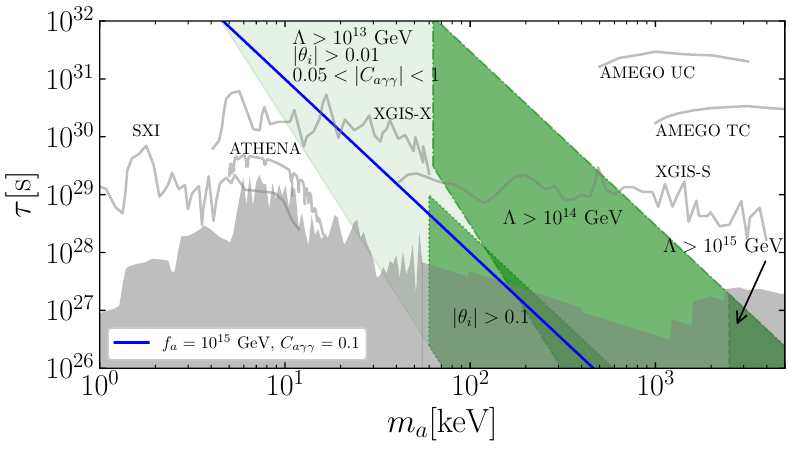
Figure 1 . Parameter space for heavy axion DM. The shaded green regions illustrate where the heavy axion can constitute all of DM subject to restrictions on Λ , the scale of the dim-6 operator mediating glueball decay, θ i , and C aγγ , as indicated. The reheat temperature after glueball decay is taken to be T RH > 5 MeV to satisfy the constraint from BBN. In grey we show existing constraint from decaying DM searches, as well as projected reaches of the proposed AMEGO (with both tracked (TC) and untracked Compoton (UC) scattering), THESEUS (with instruments SXI, XGIS- X, XGIS-S), and Athena missions. We also show the axion DM lifetime as a function of its mass for a representative choice of f a = 10 15 GeV and C aγγ = 0 . 1 . See text for more